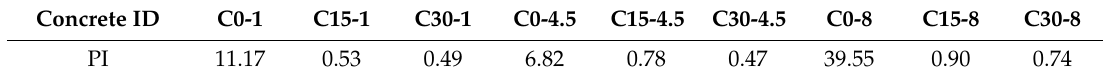
Table 7. PI values calculated on the basis of the assumptions described